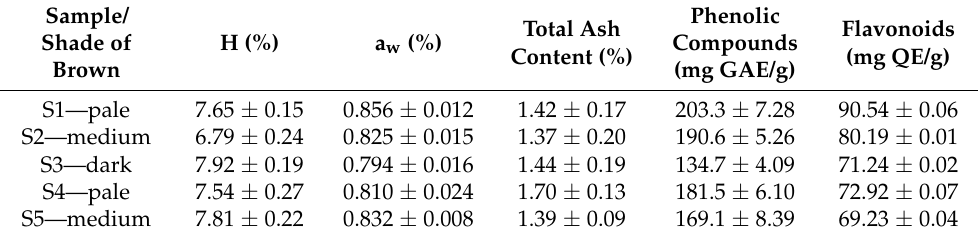
Table 1 data are expressed as means ± standard deviation of triplicate assays. Table 1. Physico-chemical parameters of the propolis samples.